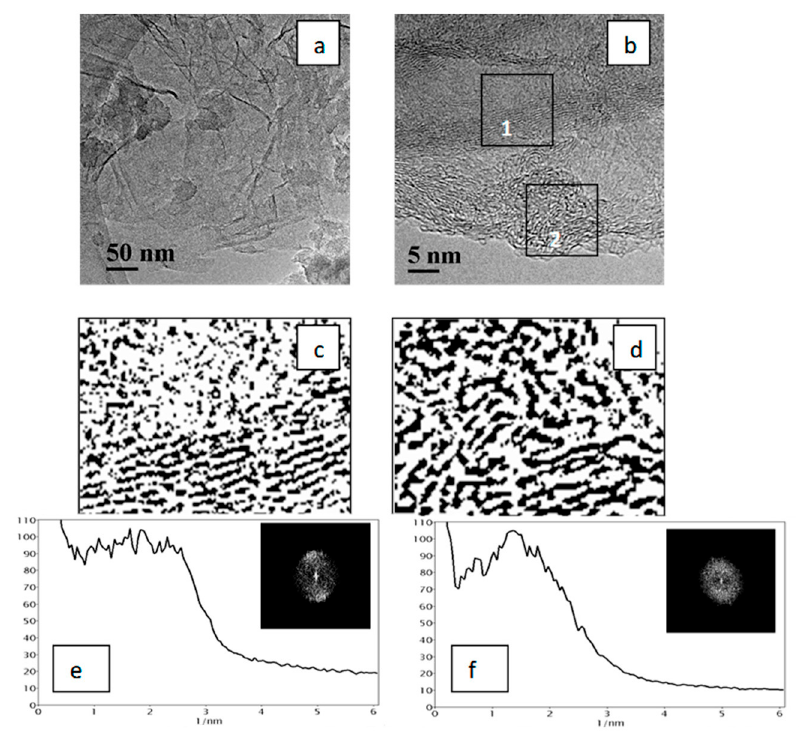
Figure 6. TEM images of the PCCNC obtained using the RGO additive ( a , b ); fragments of the TEM image ( b ) in the binary form (marked by squares): fragment 1 ( c ) and fragment 2 ( d ); RCIP obtained by processing the FFT images displayed in the insets ( e , f ) (units on the x axis correspond to the inverse distance between graphene layers, 1/nm).